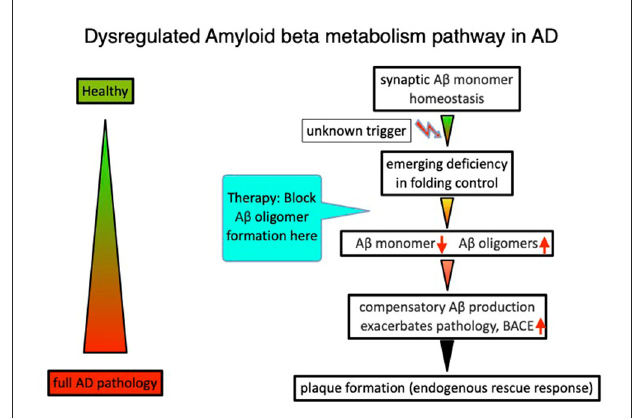
FIGURE1 The beta amyloid dysfunction hypothesis (BAD hypothesis) for Alzheimer’s disease (Hillen,